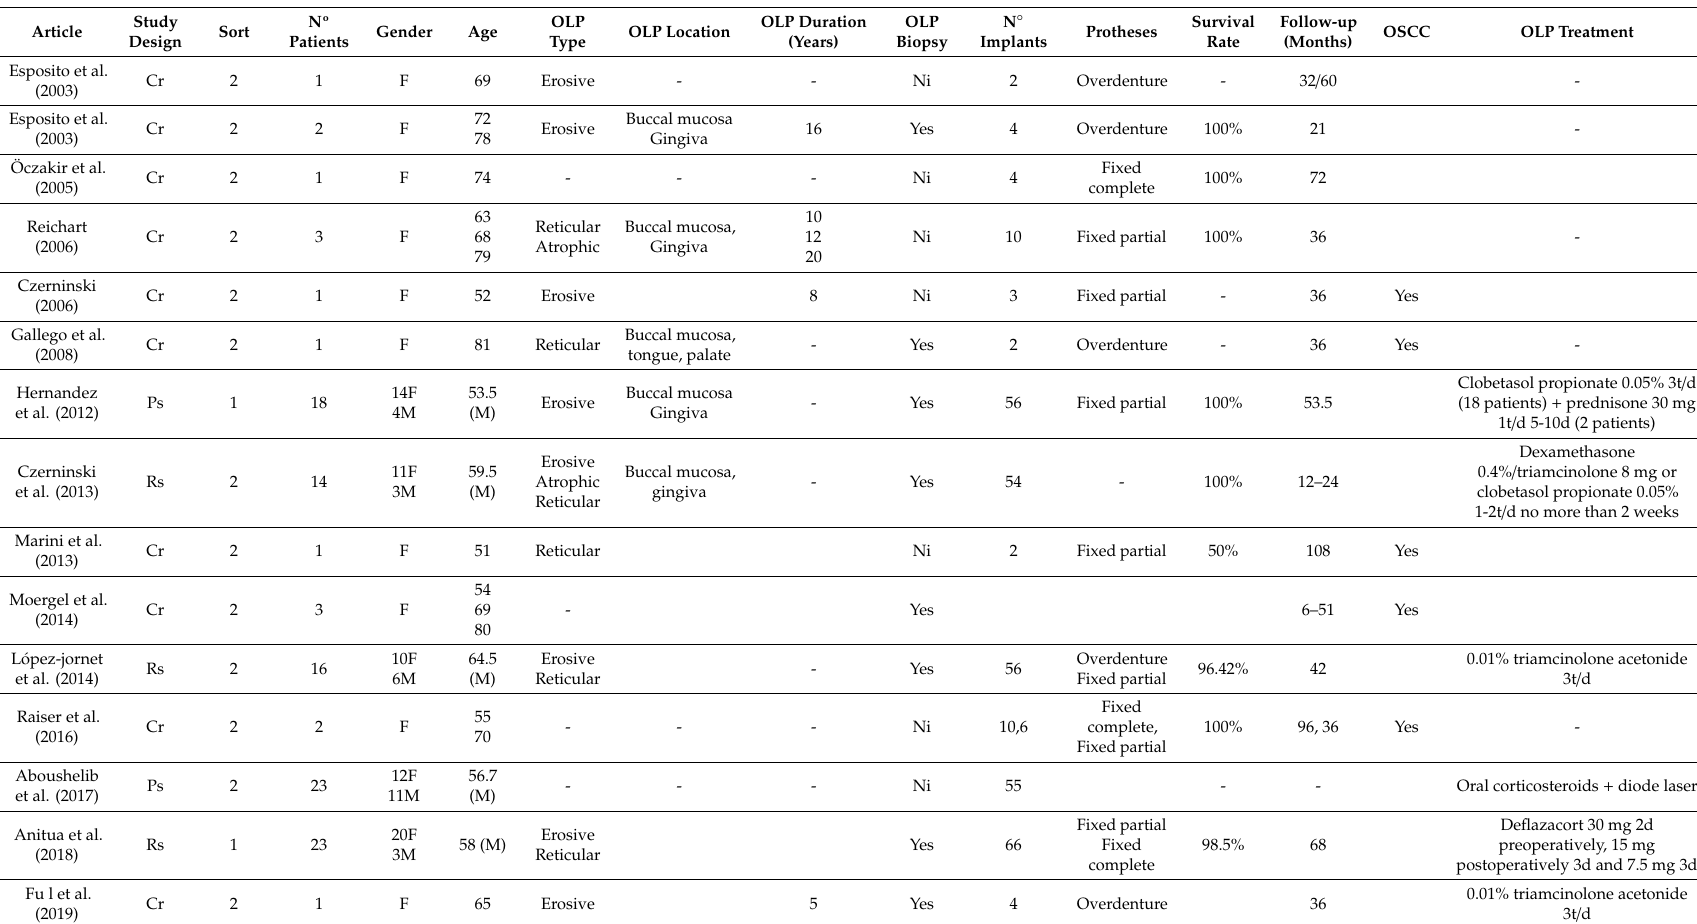
Table 1. Summary of the studies